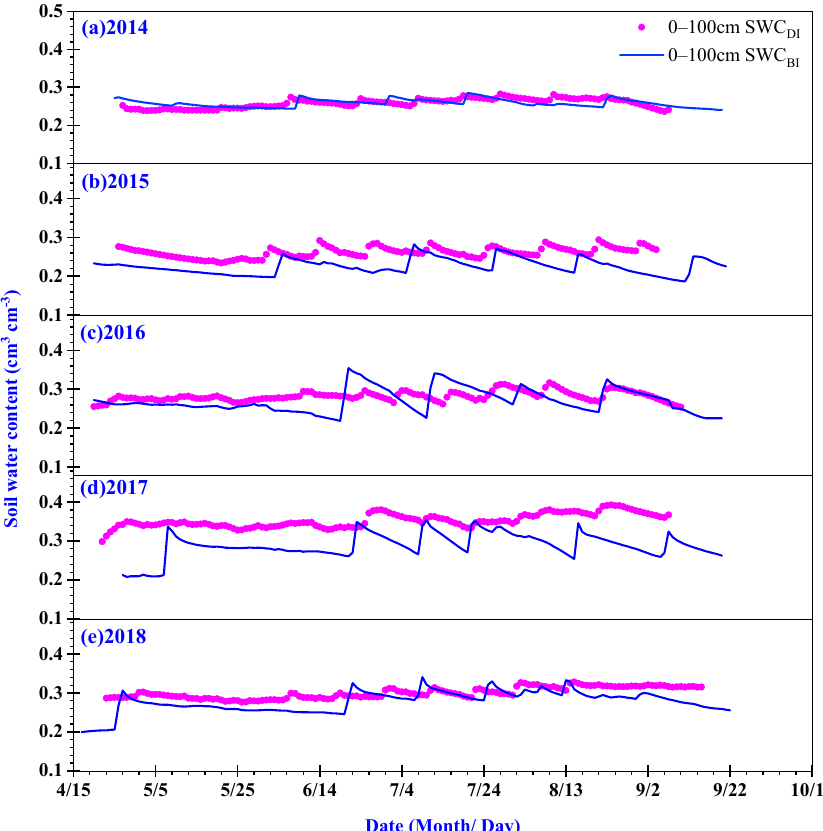
Figure 3. Seasonal variations of average soil water content of 100 cm depth measured by CS616 probes during the maize growing season from 2014 to 2018 under film mulching border irrigation (BI) treatment and film mulching drip irrigation (DI) treatment.